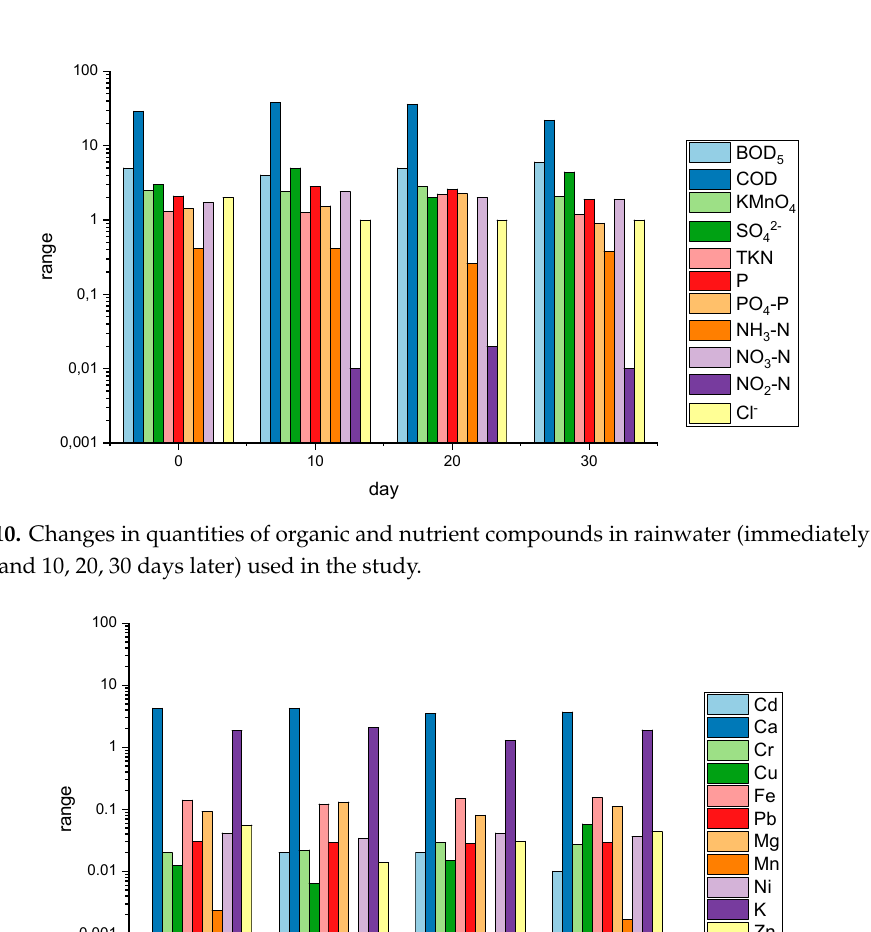
Figure 9. Physicochemical indicators of rainwater (immediately after rainfall and 10, 20, 30 days later) used in the study.